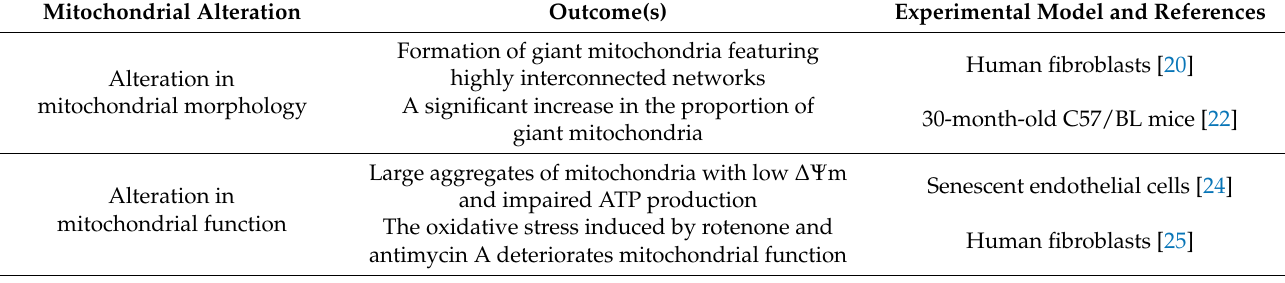
Table 1. A summary of mitochondrial alterations associated with